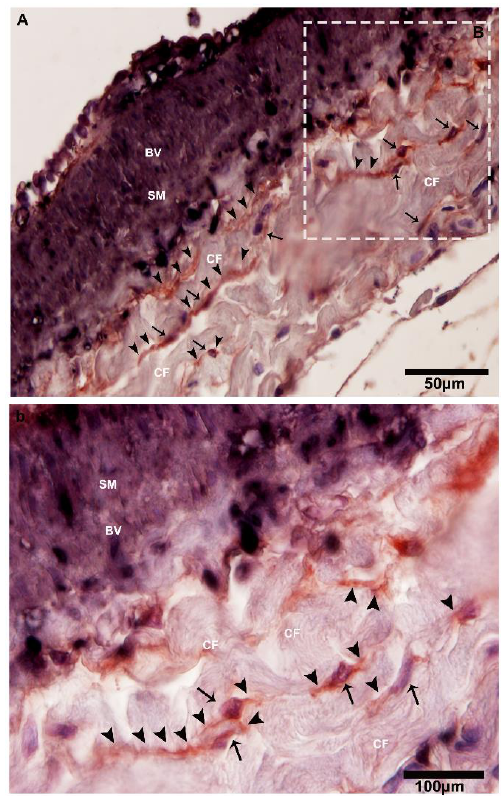
Figure 9. CD34-positive and α -SMA-positive telocytes around the large blood vessels in the connective tissue. ( A ) The square-marked area B in ( A ) is enlarged in ( b ). Immunohistochemistry (IHC) analysis shows at lower magnifications the CD34-positive and α -SMA-positive cells adjacent to large blood vessels. At high magnifications, CD34 staining has strong positivity with dilated portions, whereas α -SMA stains positive for smooth muscle layers and blood vessels. Higher and lower magnifications of IHC (two anti-bodies — CD34 and α -SMA) were used. The square-marked area B in ( A ) is enlarged in ( b ). The telocytes and their nuclei can be seen (black arrows), showing long cellular projection telopodes (black arrows head) and displaying thin and thick (podoms and podomers) segments in the vicinity of collagen fibers and adjacent to the blood vessels. BV, blood vessels; CF, collagen fibers; SM, smooth muscle. Scale bar = 50 µm in ( A ); scale bar = 100 µm in ( B ).